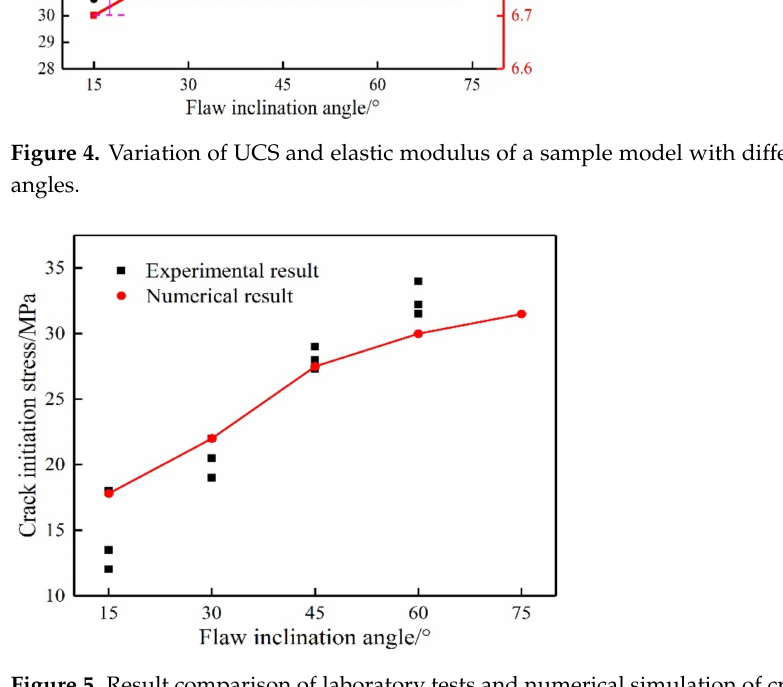
Figure 5. Result comparison of laboratory tests and numerical simulation of crack initiation stress. Figure 6 is a snapshot of different numerical models under crack initiation stress.